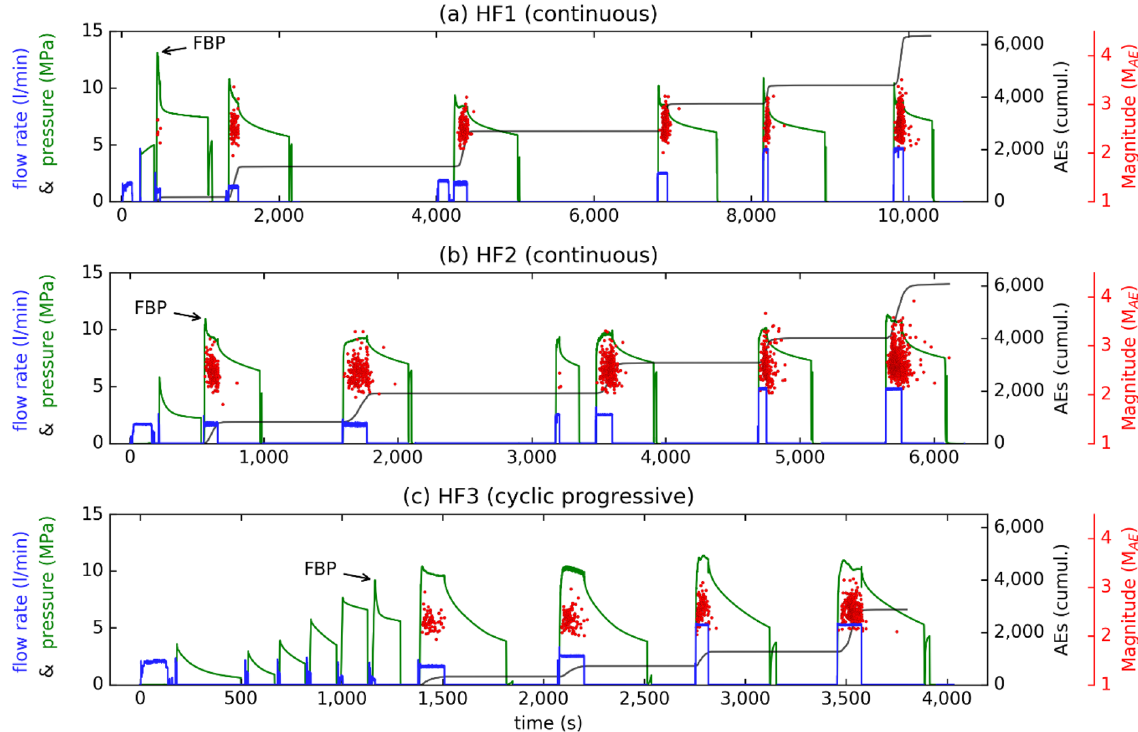
Figure 2. Results of three hydraulic-fracturing tests in Ävrö granodiorite at mine scale. HF1 ( a ) and HF2 ( b ) are conventional fracturing- and re-fracturing tests, respectively, with continuous water injection. HF3 ( c ) is a fatigue test with cyclic, progressive fluid injection before the occurrence of breakdown pressure. Left ordinate indicates flow rate ( blue ) and fluid pressure ( green ). Right ordinate shows cumulative number of AEs ( black curve ) and their magnitudes ( red dots ) over time (s) in the